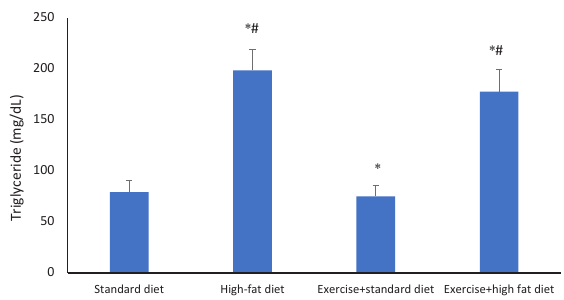
Figure 1. Triglyceride levels among groups. Note . * Indicates a significant difference with the group receiving the standard diet ( P < 0.05). # Represents a significant difference with exercise + standard diet ( P < 0.05).